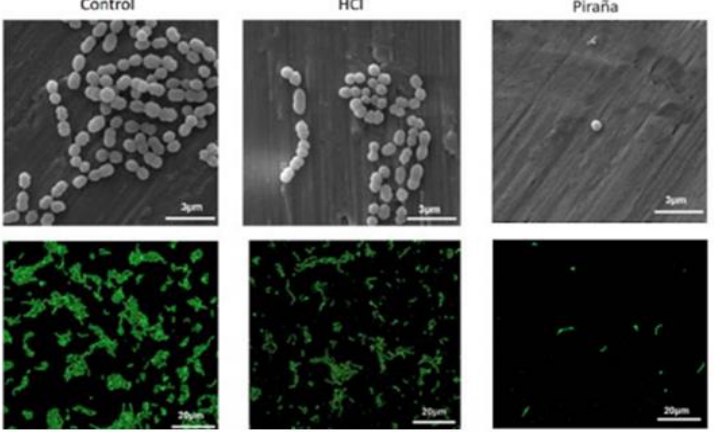
Figure 11. SEM ( top row ) and fluorescence ( bottom row ) images of S. sanguinis stained by LIVE/DEAD.